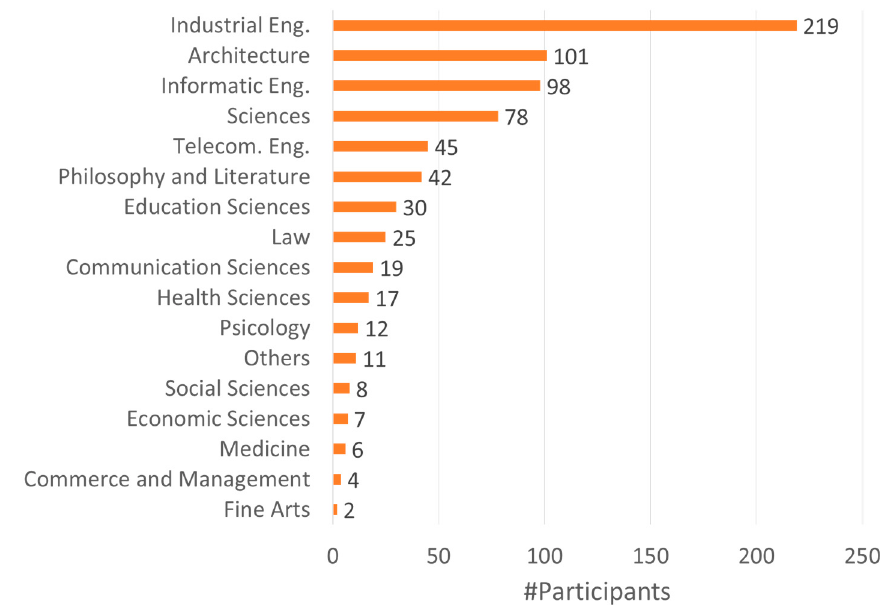
Figure 15. Participants in relation to their field of knowledge.